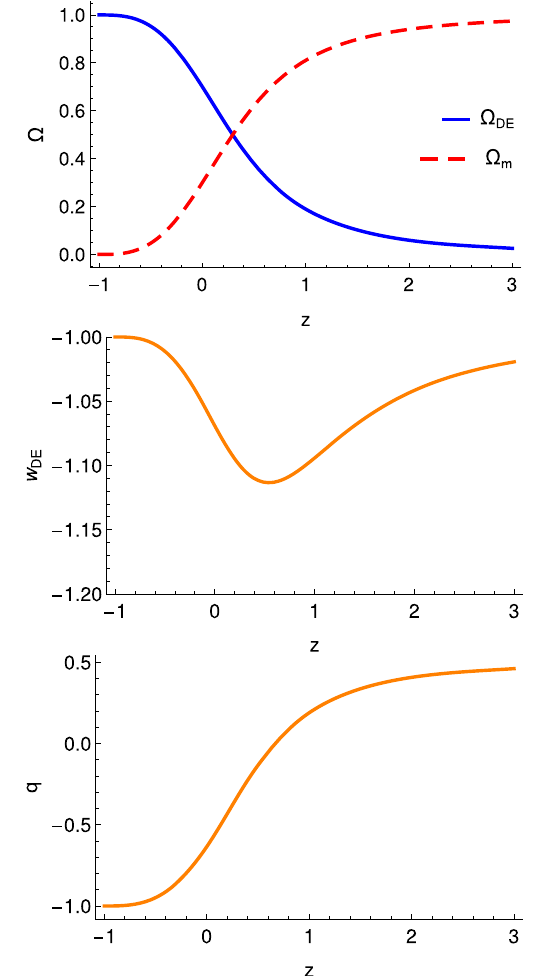
Fig. 3 Upper graph: The evolution of the effective dark energy den- sity parameter (cid:4) DE (blue-solid) and the matter density parameter (cid:4) m (red-dashed) respectively, as a function of the redshift z , for the modi- fied scenario through Kaniadakis entropy. Middle graph: The evolution of the effective dark energy equation-of-state parameter w DE . Lower graph:Evolutionofthedecelerationparameter q .InallgraphstheKani- adakis entropic parameter is K = 0 . 2 in units of k B , while (cid:2) is given by (25), and we have fixed (cid:4) m ( z = 0 ) = (cid:4) m 0 ≈ 0 . 3